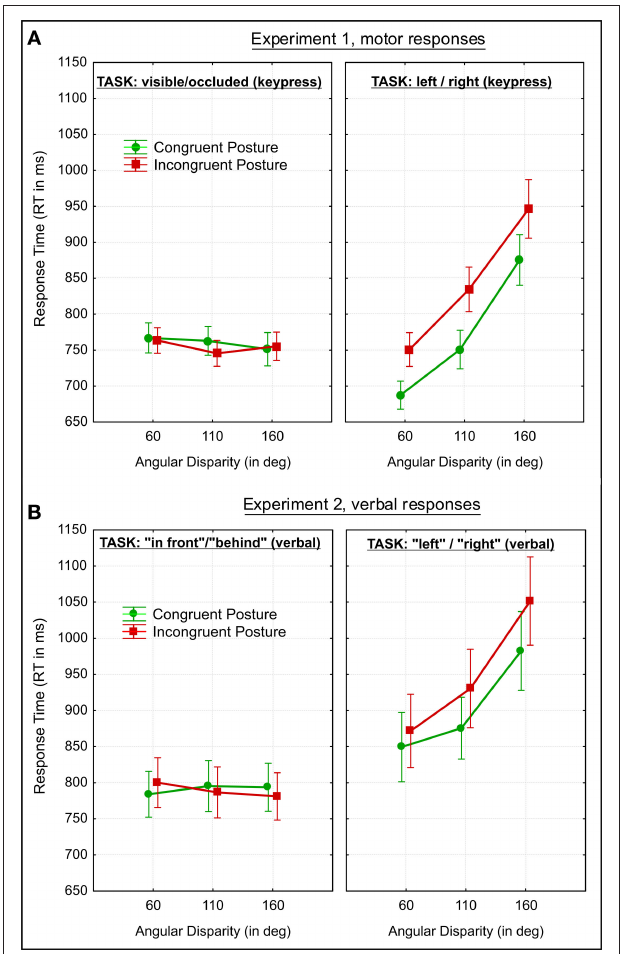
Figure 3 | results for experiment 1 and 2 in the combined analysis. Group mean response times (RT) for (A) Experiment 1 and (B) Experiment 2. Vertical bars denote the standard error of mean. Further explanations in the